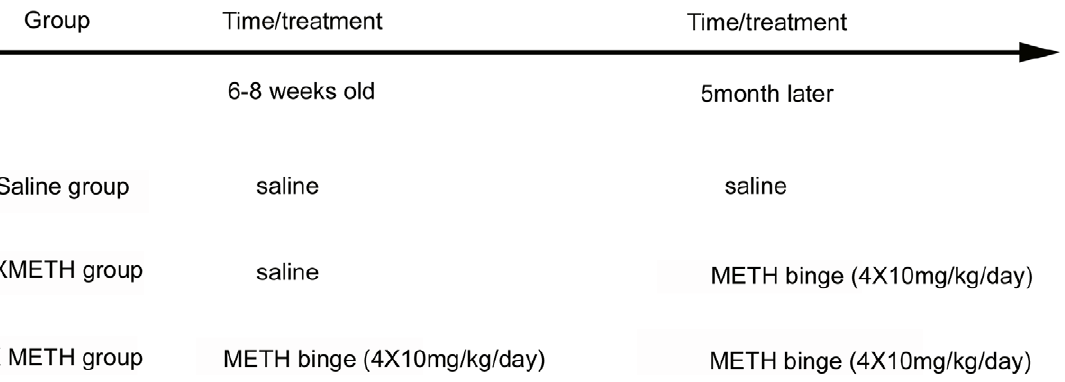
Figure 2. Treatment groups and schedules. Each group contained both Nurr1 + / + and + / 2 mice. Saline group mice received saline injections when they were 6–8 weeks old and 5 months later. 1XMETH group mice received saline injections when they were 6–8 weeks old and received 1XMETH binge treatment (4X10 mg/kg) 5 months later. 2XMETH group mice received METH binge treatment (4X10 mg/kg) at both time points.